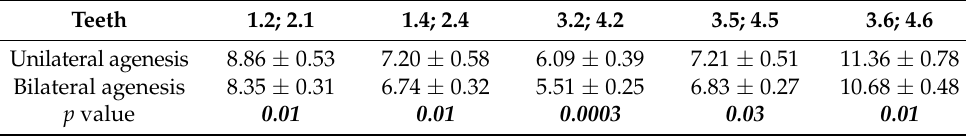
Table 6. Mean values of mesio-distal dimension in case of teeth with significant